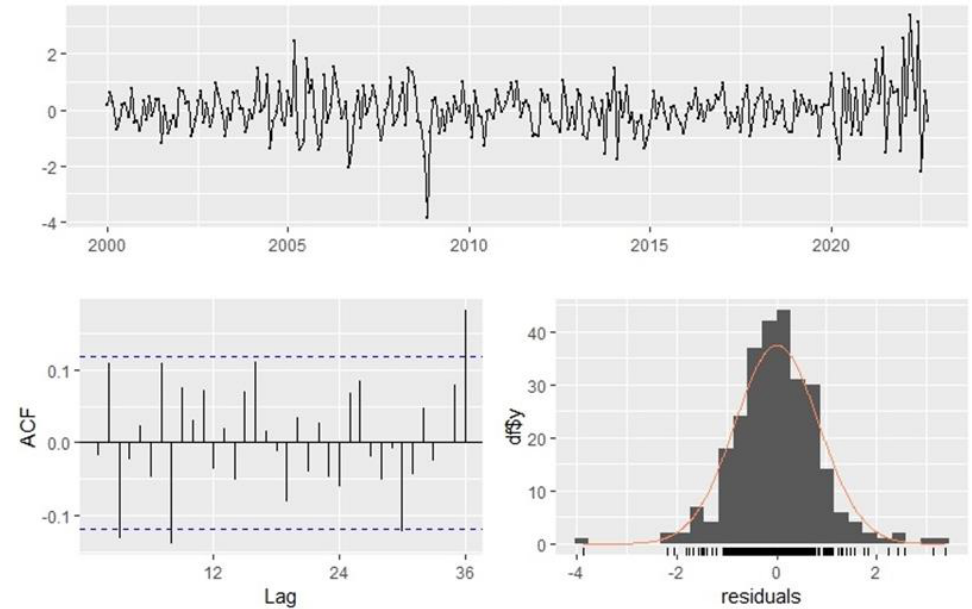
Figure A2. Residuals, ACF, and lags in prediction of CPI New York. Own processing.